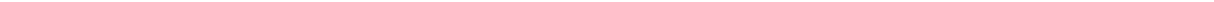
Fig. 1 Feeders maintain telomeres of ESCs. a Representative telomere Q-FISH images of N33 and AG-J2 ESCs cultured on gelatin or feeder. blue, chromosomes stained by DAPI; green dots, telomeres; white arrows indicate chromosome fusion. Scale bar, 10 μ m. b Histogram shows distribution of relative telomere length displayed as TFU by Q-FISH analysis. Green line indicates medium telomere length. Mean ± s.d. of telomere length is shown above each panel. Heavy black bars on Y -axis show the frequency of telomere signal-free ends. Telomere length was measured at passage 8 for N33 ESCs and passage 20 for AG-J2 ESCs under feeder or feeder-free conditions. P values were calculated by Wilcoxon – Mann – Whitney rank sum test. c Telomere length distribution shown as TRF by Southern blot analysis of N33 ESCs at passage 10, F1 ESCs at passage 21 and AG ESCs at passage 5 cultured with or without feeders. d Frequency of telomere signal-free ends indicative of shortest telomere per metaphase. e Frequency of chromosome fusion per metaphase. Mean ± s.e.m. f Distribution of chromosome numbers in ESCs cultured with or without feeders for 8 – 10 passages. n = number of spread analyzed. g Immuno fl uorescence images of Trf1 (red) and γ H2AX (green). Colocalized foci are indicated by arrowheads. Scale bar, 5 μ m. h Percentage of ESCs with colocalized foci of Trf1 and γ H2AX. n = 100 nuclei counted from the images captured in g . * P < 0.05, ** P < 0.01, ns not signi fi cant ( P > 0.05). Student ’ s t -test for c – e , and χ 2 test for f and